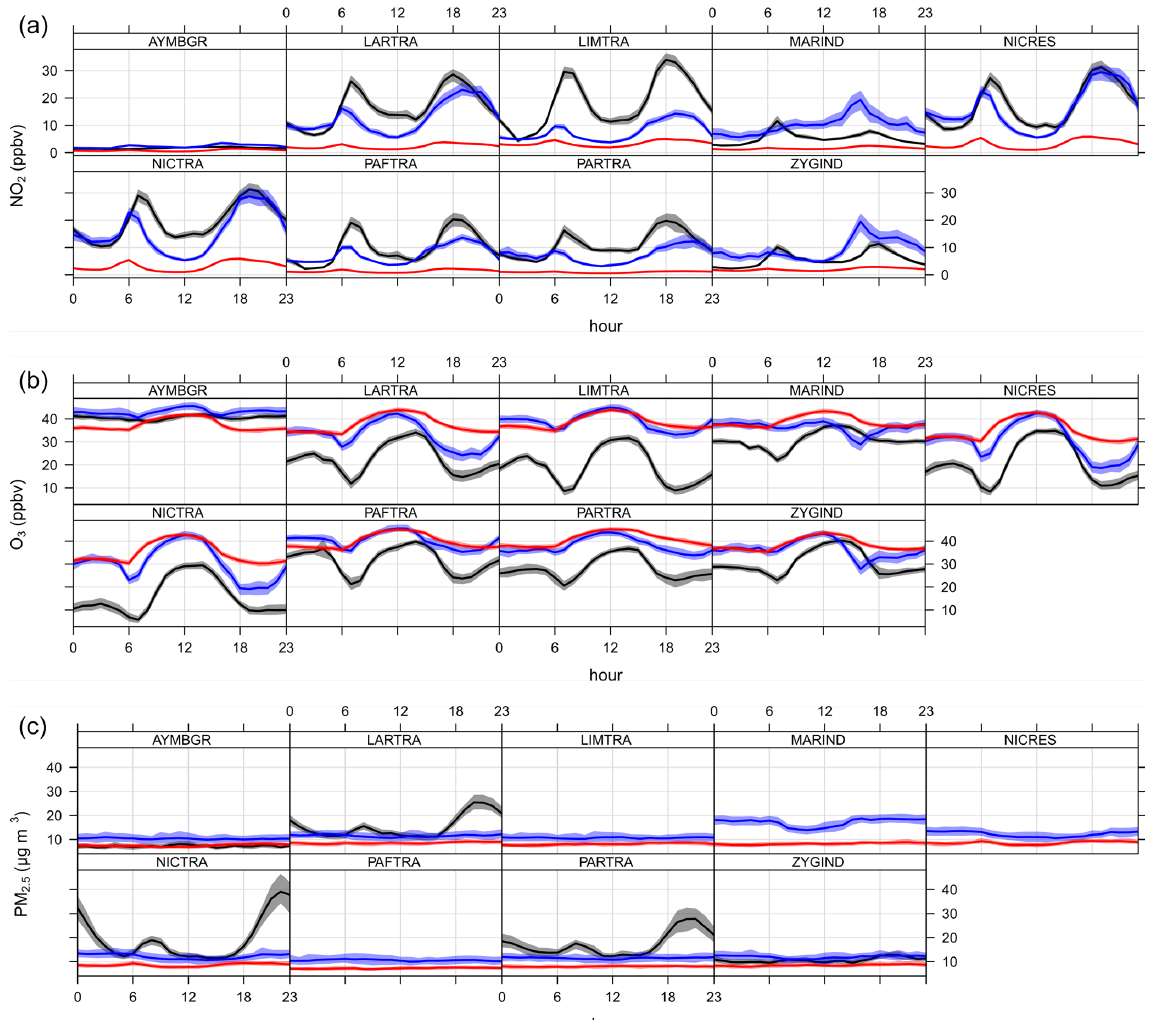
Figure 6. Diurnal variation of NO 2 (a) , O 3 (b) , and PM 2 . 5 (c) in observations (grey lines), the WRF-Chem (blue lines) and the CAMS (red lines) first day of forecast during